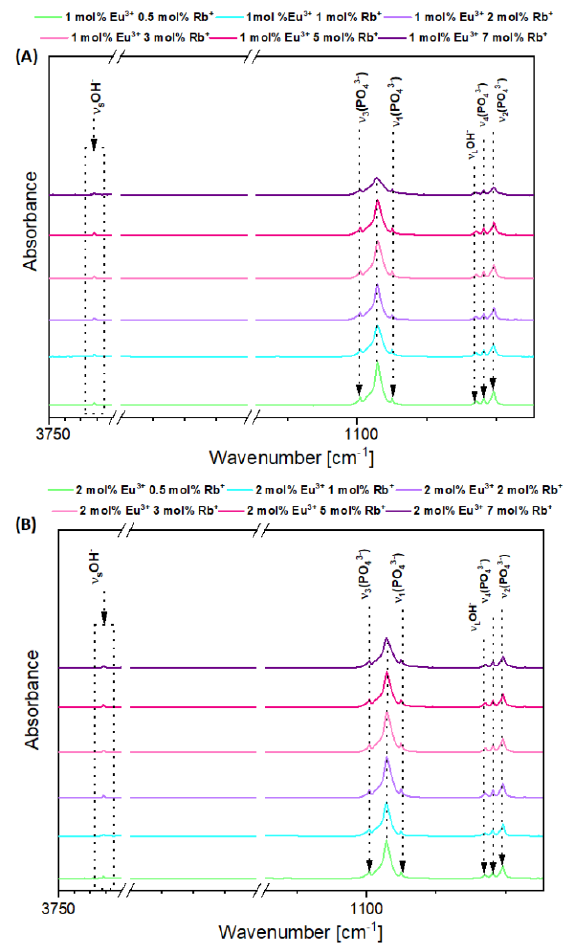
Figure 2. FT-IR spectra of Ca 10 − (0.1 + x) Eu 0.1 Rb x (PO 4 ) 6 (OH) 2 ( A ) and Ca 10 − (0.2 + x) Eu 0.2 Rb x (PO 4 ) 6 (OH) 2 ( B ), where x equals 0.5, 1, 2, 3, 5, 7 mol% of Rb +